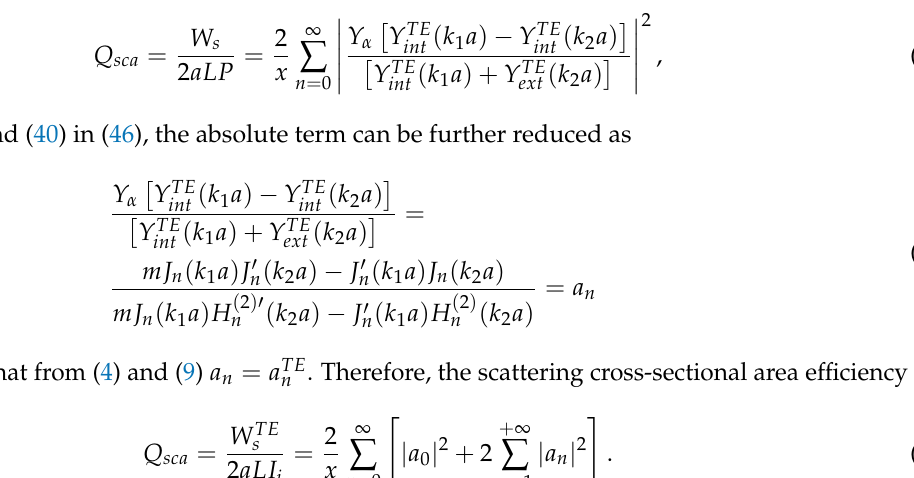
Figure 6. For the excitation of TE mode, a voltage generator V TE n at the boundary of metallic nanowire, get distributed as internal ( V TE properties ( k 1 / k 2 ) of the internal medium as shown in Figure 4a,b. Whereas Y n internal admittance of the nanocylinder with property k 1 / k 2 and Y TM the